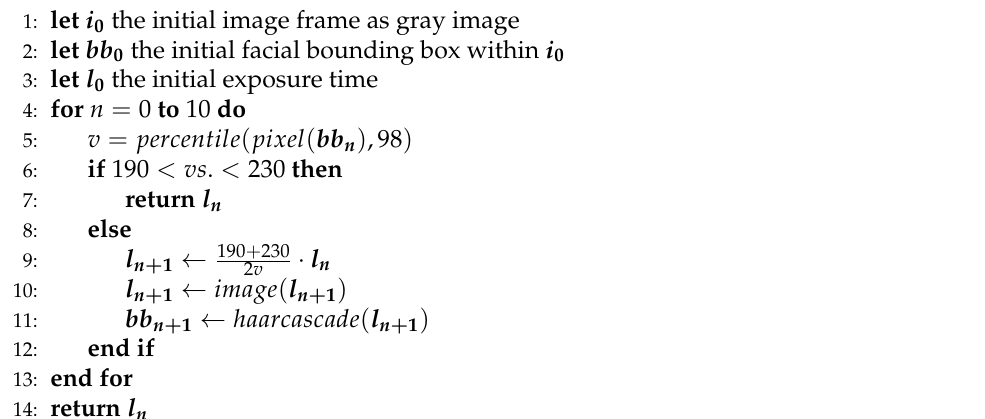
Algorithm 1 Automatic exposure time adjustment with respect to a person’s face